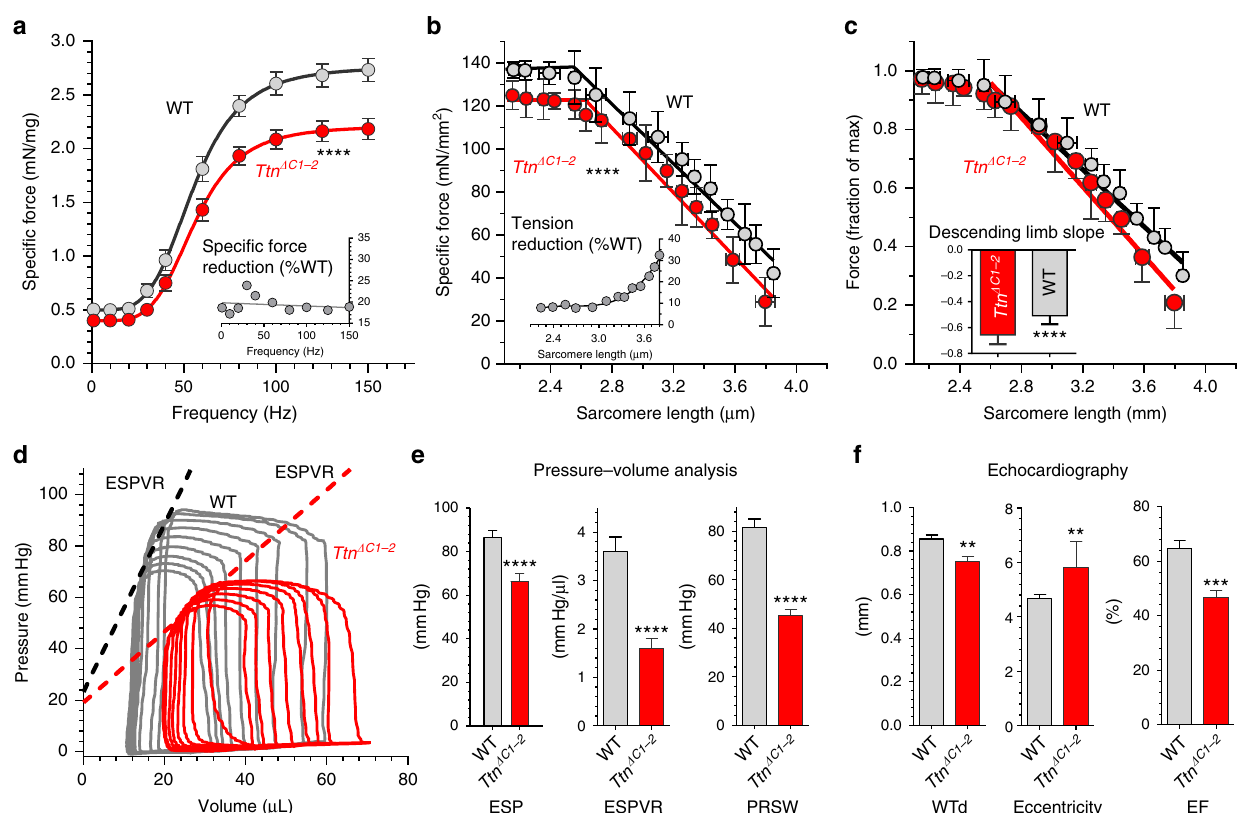
Fig. 3 Functional effects of deleting C-zone repeats of skeletal muscle and the heart. a In vivo force generation by the gastrocnemius muscle complex. The speci fi c force frequency relation revealed signi fi cantly reduced force levels in Ttn Δ C1-2 mice (see inset). b , c Force – sarcomere length relations of skinned fi ber bundles from EDL muscle activated by maximal calcium levels. b Speci fi c force is signi fi cantly reduced in Ttn Δ C1-2 mice (red symbols) with a reduction that, relative to WT levels, increases with sarcomere length (inset). c Force normalized to maximal force at optimal length reveals a descending limb with a slope that is signi fi cantly steeper in Ttn Δ C1-2 mice (inset). Mice at 60 days of age were used ( n = 6 male and 2 female WT; n = 7 male and 2 female Ttn Δ C1-2 ). d , e Pressure – volume (PV) analysis of the left ventricular chamber. Sample PV loops in Fig. 3d reveal reduced end-systolic pressures and a reduced slope of the end-systole PV relation (ESPVR) in Ttn Δ C1-2 mice (red), with summarized results in Fig. 3e. Male mice at 62 – 74 days of age were used ( n = 7 WT and n = 8 Ttn Δ C1-2 ). f Echocardiography revealed wall thinning (diastolic wall thickness (WTd)), an increased eccentricity index, and a reduced ejection fraction (EF), all indicating that Ttn Δ C1-2 mice have dilated cardiomyopathy (DCM). The 50-day-old male mice were studied ( n = 8 WT and n = 8 Ttn Δ C1-2 ). Mean values ± s.e.m. are shown. Additional statistical analysis is provided in Supplementary Table 4 (** denotes p <